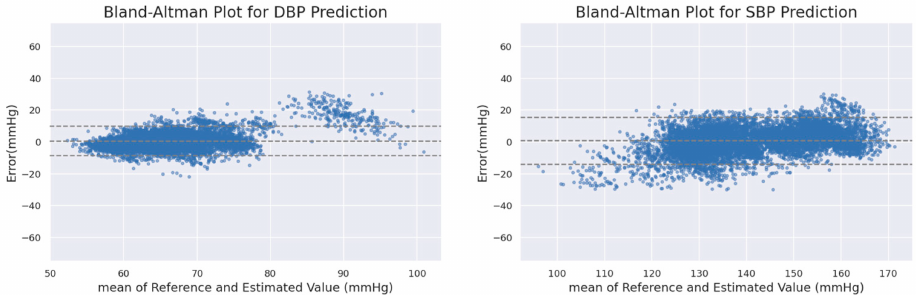
Figure 3. Bland–Altman plots for BP